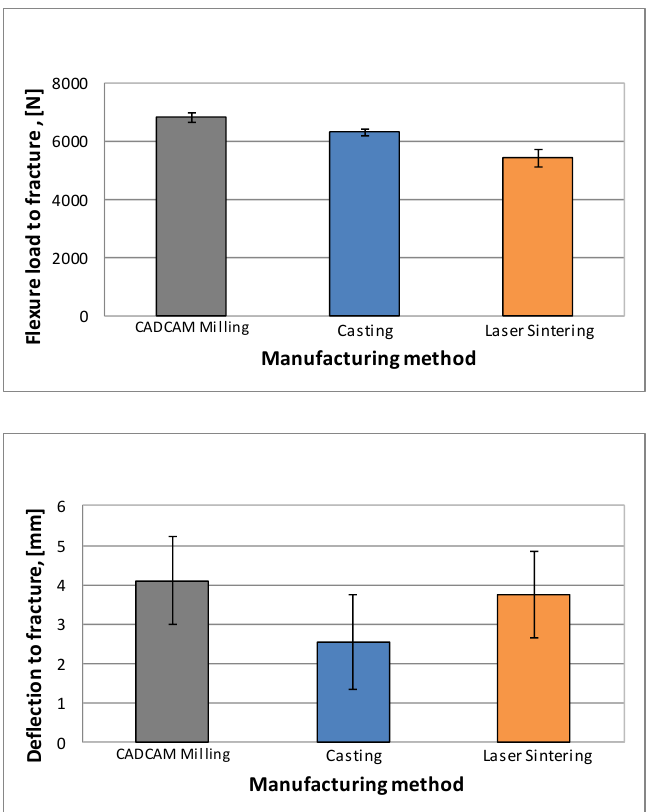
Figure 9. Flexural load to fracture and deflection to fracture obtained by three point bending for each dental restoration method. dental restoration